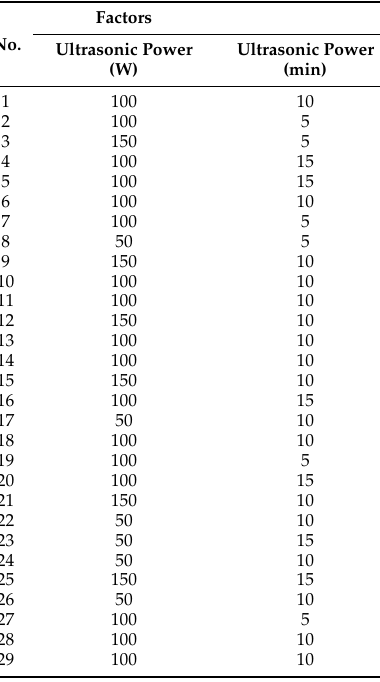
Table 1. Box–Behnken design (3-level-4-factor) for curcumin-loaded Pickering emulsion delivery system and response surface analysis of experimental